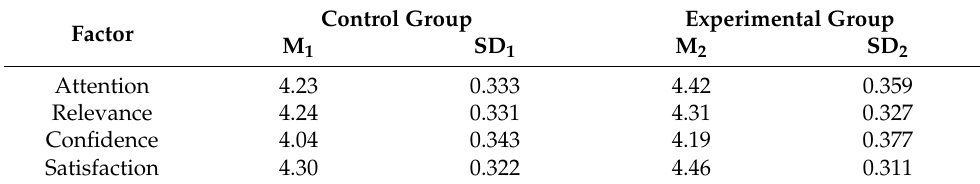
Table 5. Descriptive statistics for all subscales of IMMS